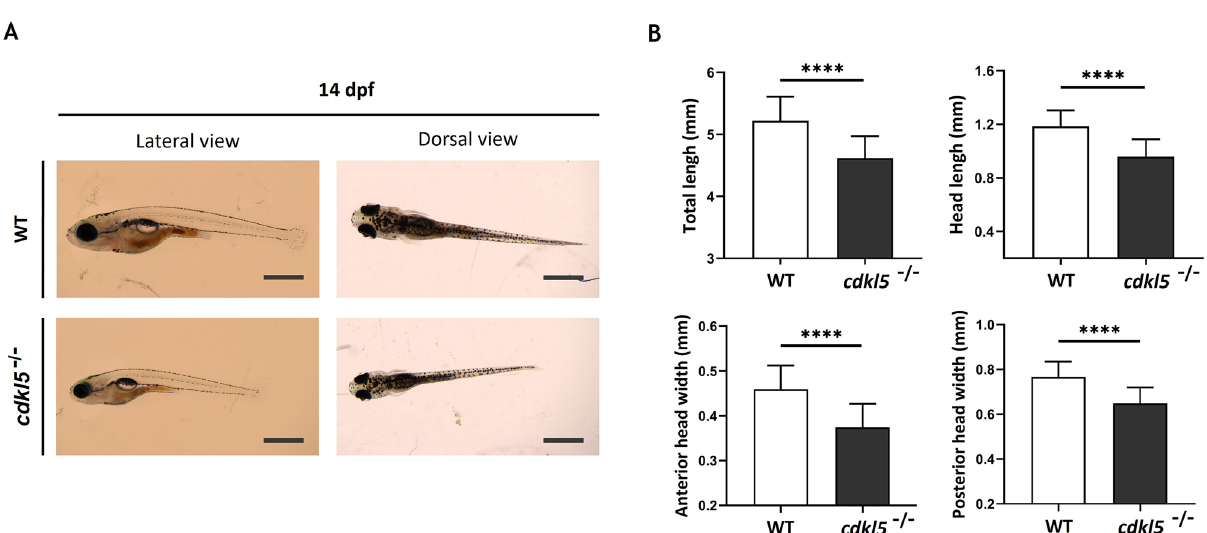
Figure 3. Morphological analysis of cdkl5 sa21938 mutant at 14 dpf. ( A ) Representative lateral and dorsal images of wild-type (WT) and homozygous ( cdkl5 −/− ) mutant larvae. Scale bar = 1 mm. ( B ) Morphometric analysis of WT (n = 30) and cdkl5 −/− (n = 25) larvae. Data are presented as mean ± SD. Three independent experiments were performed. Statistical analysis was performed using t-test with Welch’s correction. **** indicate p <